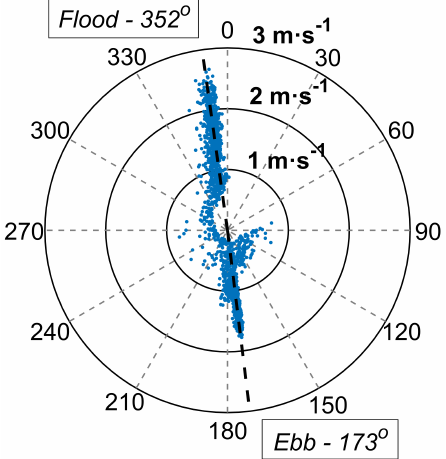
Figure 2. Flow strength and directionality data obtained at the turbine location prior to its